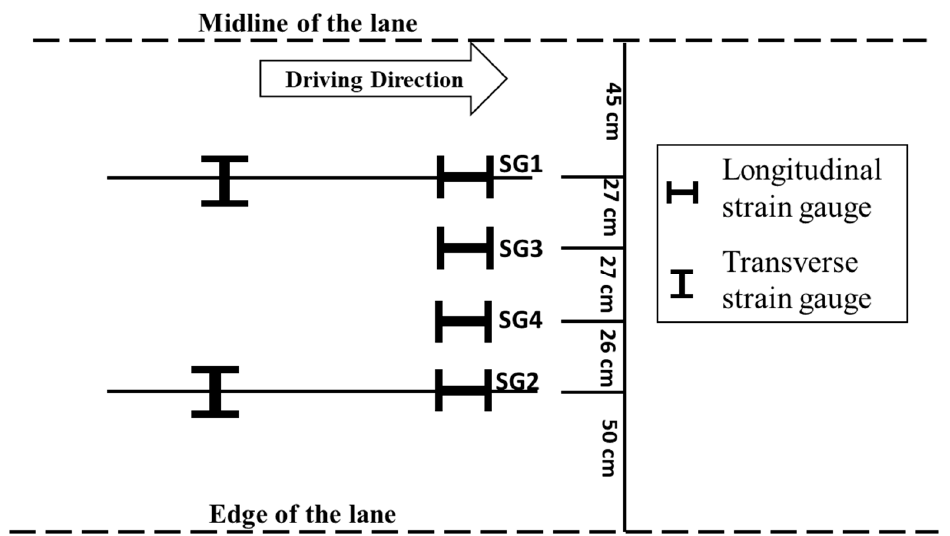
Figure 4. Strain gauge array of the test section.